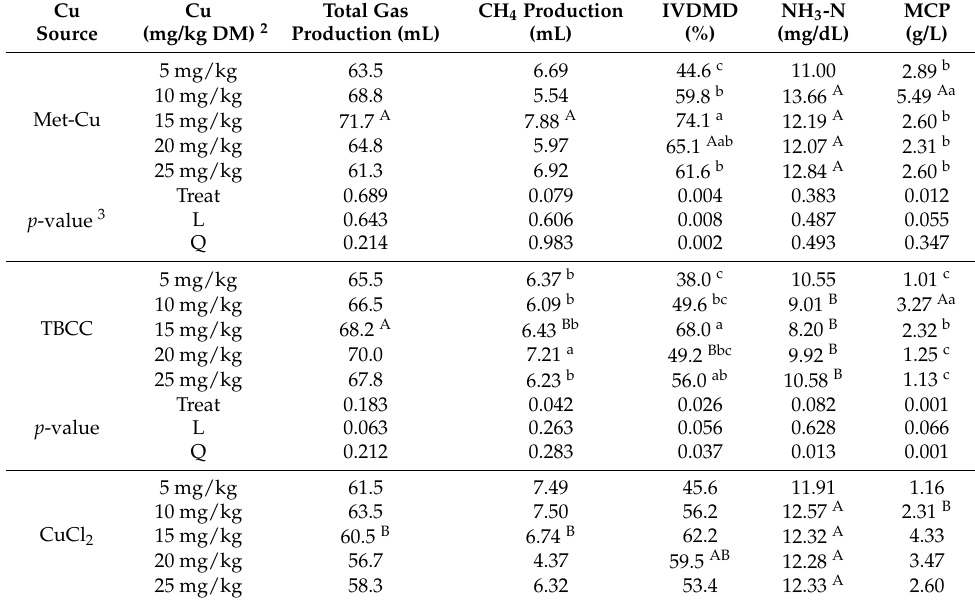
Table 2. In vitro total gas and methane (CH 4 ) productions, dry matter degradability (IVDMD), ammonia nitrogen (NH 3 -N) and microbial protein (MCP) from substrate with added copper (Cu) from different sources at different levels 1